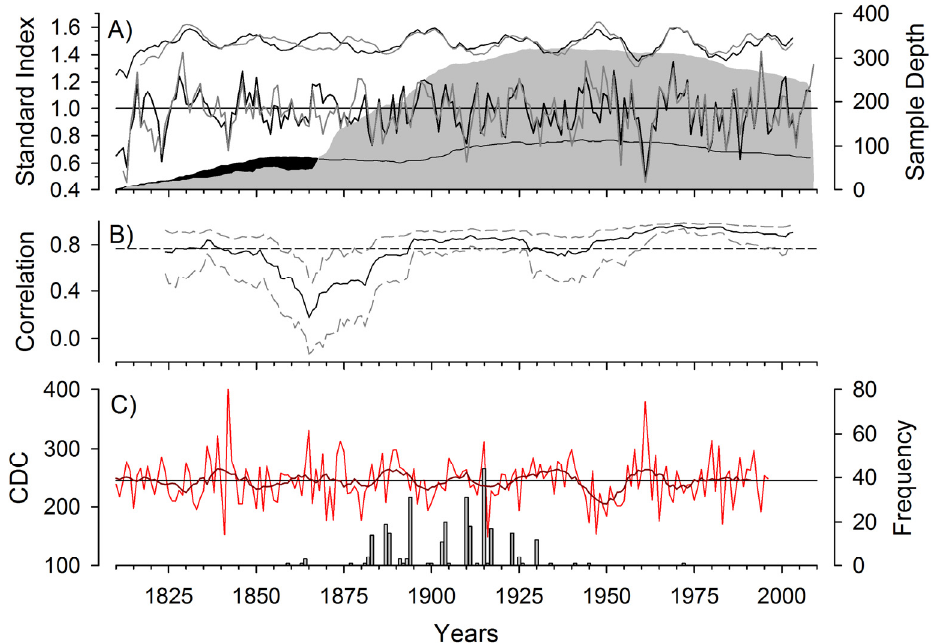
Figure 9. Pinus banksiana standard tree-ring chronology and sample depth ( A ) developed from trees inside (gray line) and outside (black line) the LKFMU. The upper lines represent their respective 11-year moving average. Thirty-year running correlations between the two chronologies are plotted with 95% CI ( B ). The dashed line indicates the mean correlation value. Reconstructed Canadian Drought Code (with 11-year moving average) for the Manitoba boreal plains [63] and recorded fire scar within LKFMU ( C ).